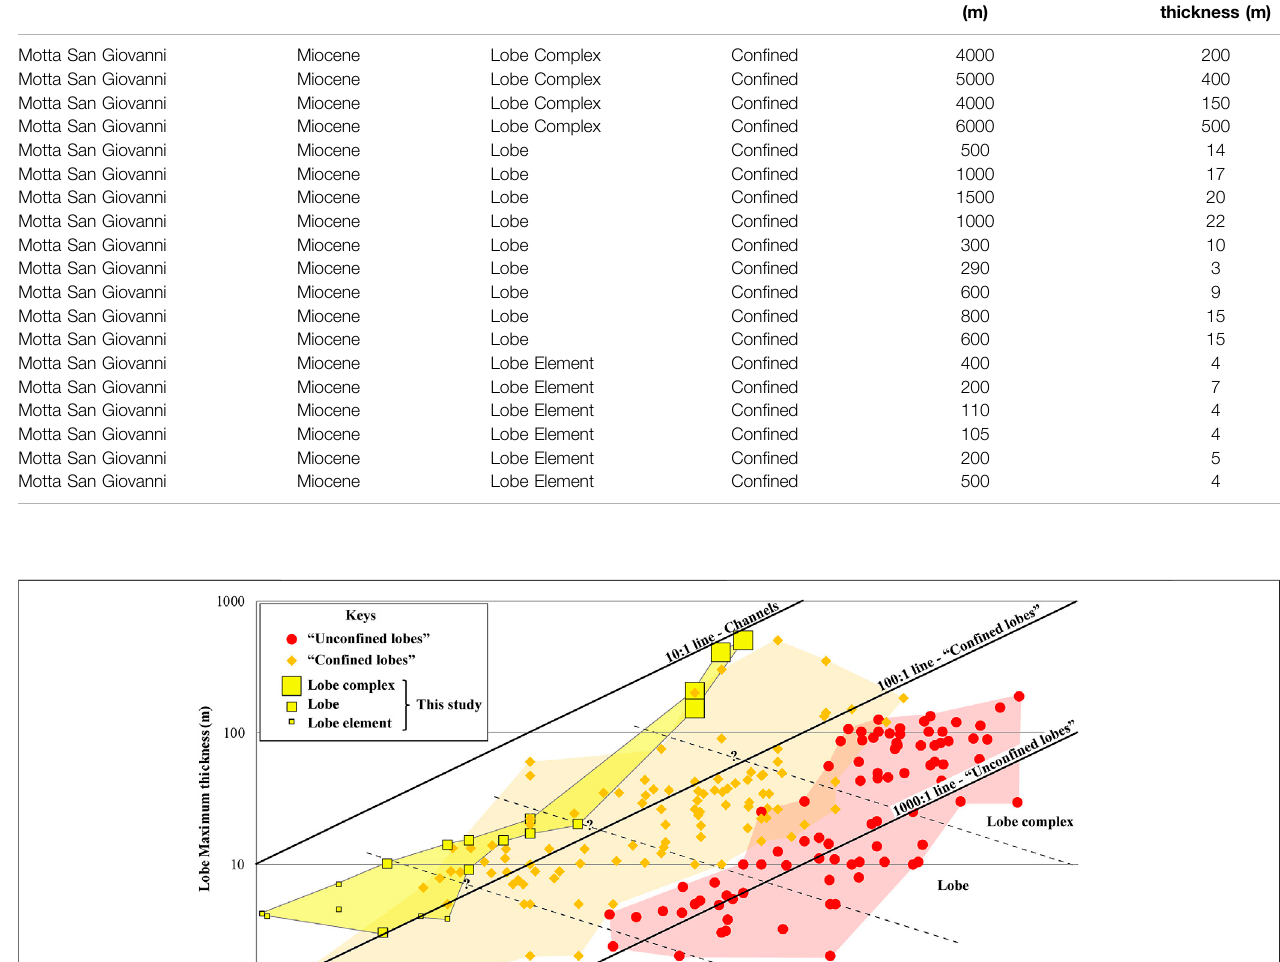
TABLE 1 | Dimensions of Lobe Complexes, Lobes and Lobe elements in the Motta San Giovanni Formation (Miocene, Calabria) quanti fi ed from the 3D outcrop models. Formation